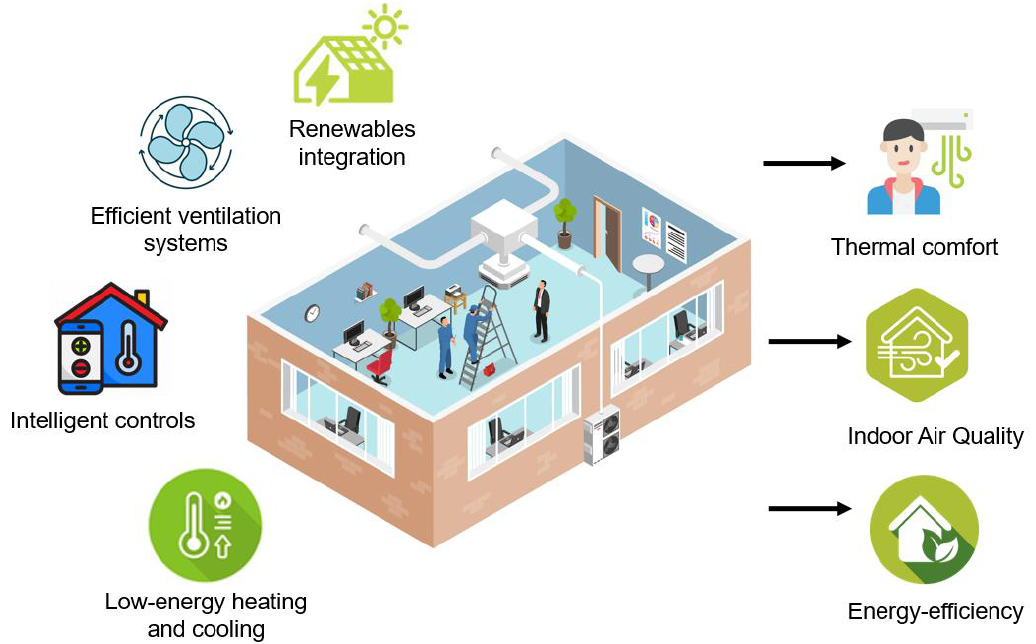
Figure 2. An overview of the key areas covered in the special issue. Image adapted from [15].